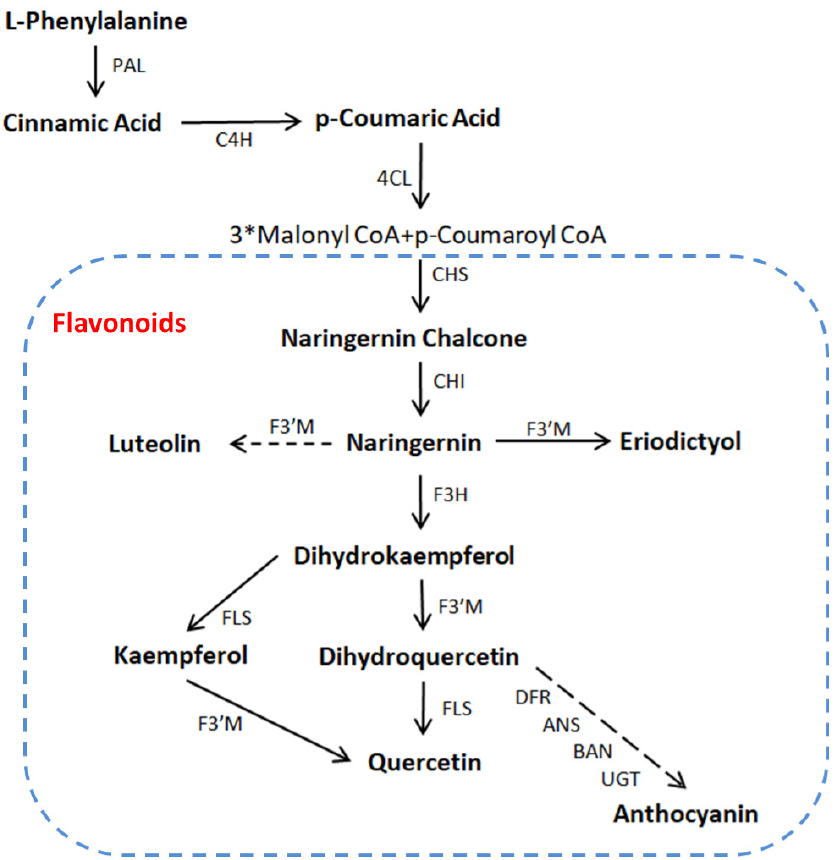
Figure 3. Flavonoid biosynthesis pathway. Gene abbreviations were taken from KEGG (www.genome.jp/kegg/pathway accessed on 14 August 2021) for plants. PAL, phenylalanine ammonia lyase; C4H, cinnamate 4-hydroxylase; 4CL, 4-coumarate: CoA ligase; CHS, chalcone synthase; CHI, chalcone isomerase; F3H, flavanone 3-hydroxylase; F3 (cid:48) M, flavonoid 3 (cid:48) -monooxygenase; FLS, flavonol synthase; DFR, dihydroflavonol 4-reductase; ANS, anthocyanidin synthase; BAN, banyuls; UGT, UDP-glucosyl transferase